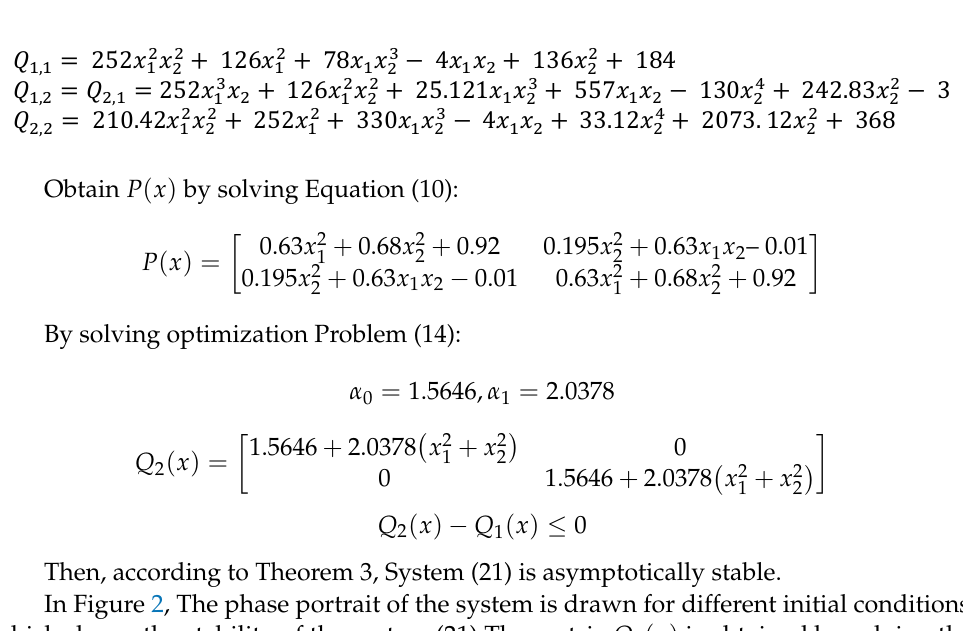
Figure 1. Proposed method to check the stability of fractional-order systems based on the frequency response.